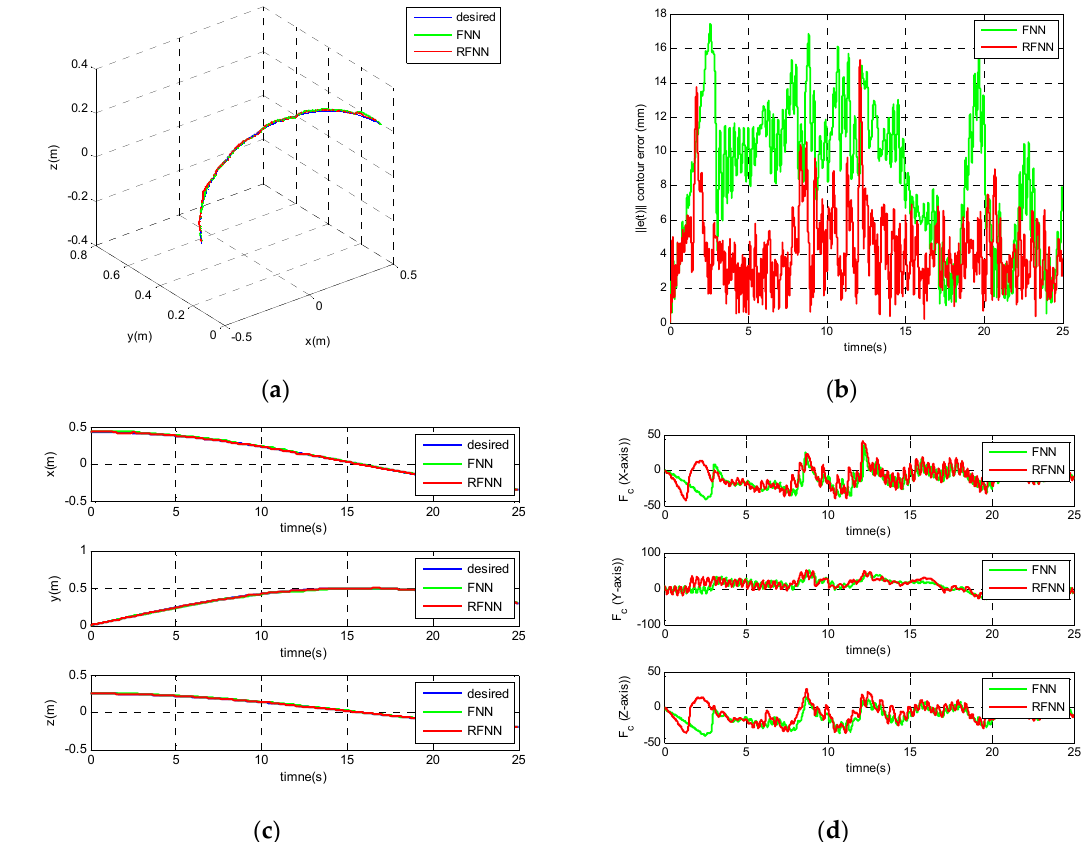
Figure 8. Comparison results of adaptive controller using RFNN and fuzzy neural network (FNN), ( a ) system trajectory in X-Y-Z plane, ( b ) performance of contour error; ( c ) trajectories of each axis, ( d ) Control effort. Table 2. Comparison performance of FNN and RFNN.